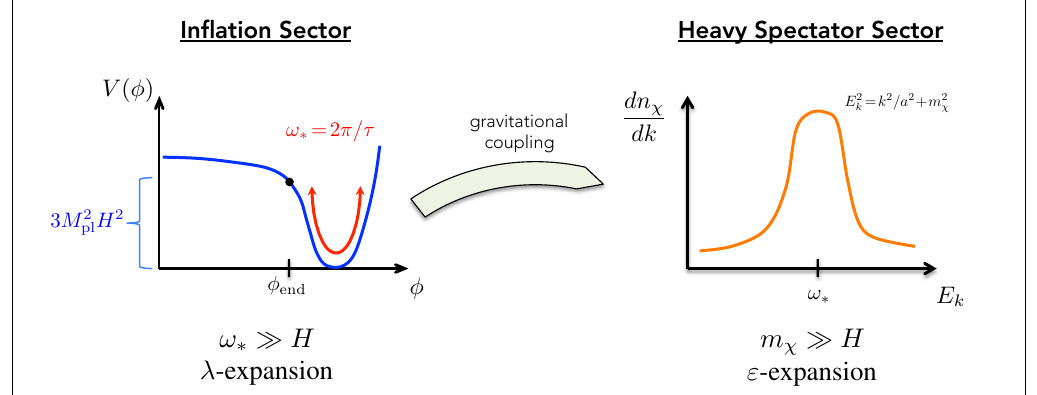
Figure 1 . Rapid oscillations of the in(cid:13)aton (cid:12)eld at the end of in(cid:13)ation lead to the production of heavy spectator particles via the coupling of each (cid:12)eld to gravity. In the regime where the in(cid:13)aton (cid:12)eld oscillates quickly, ! H , and the spectator particles are heavy, m (cid:31) H , we show that an (cid:29) (cid:3) (cid:29) the particle spectrum can be calculated analytically using the Bogoliubov